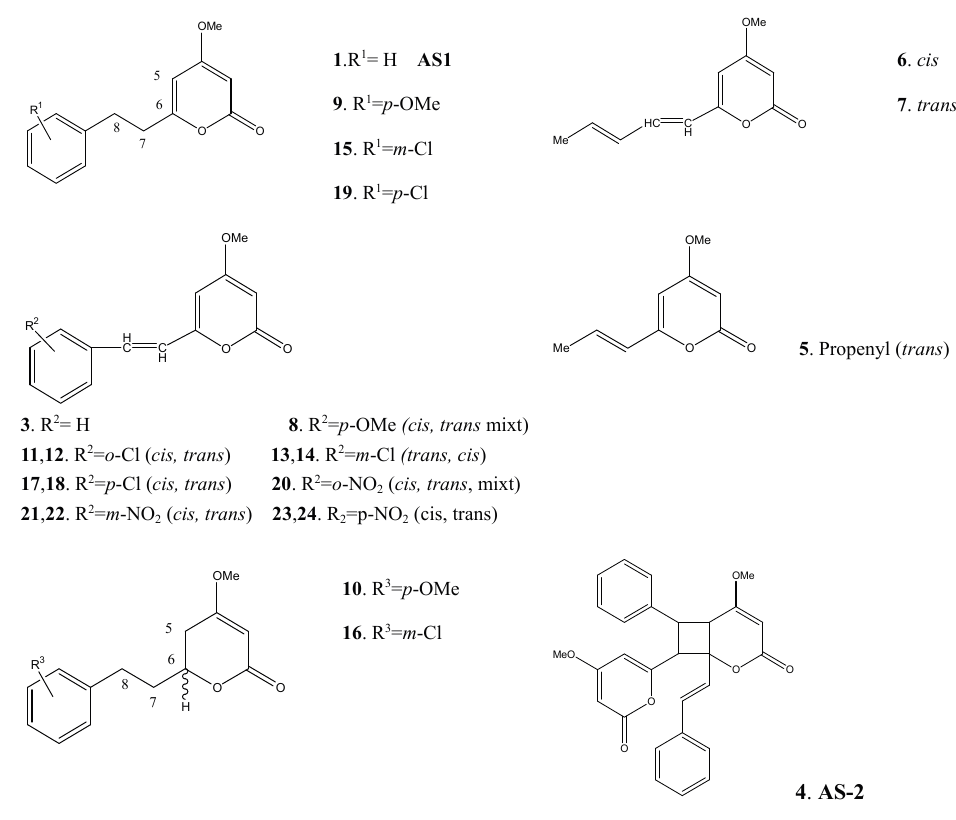
Figure 3. Some DDK derivatives synthesized by Fujita et al.